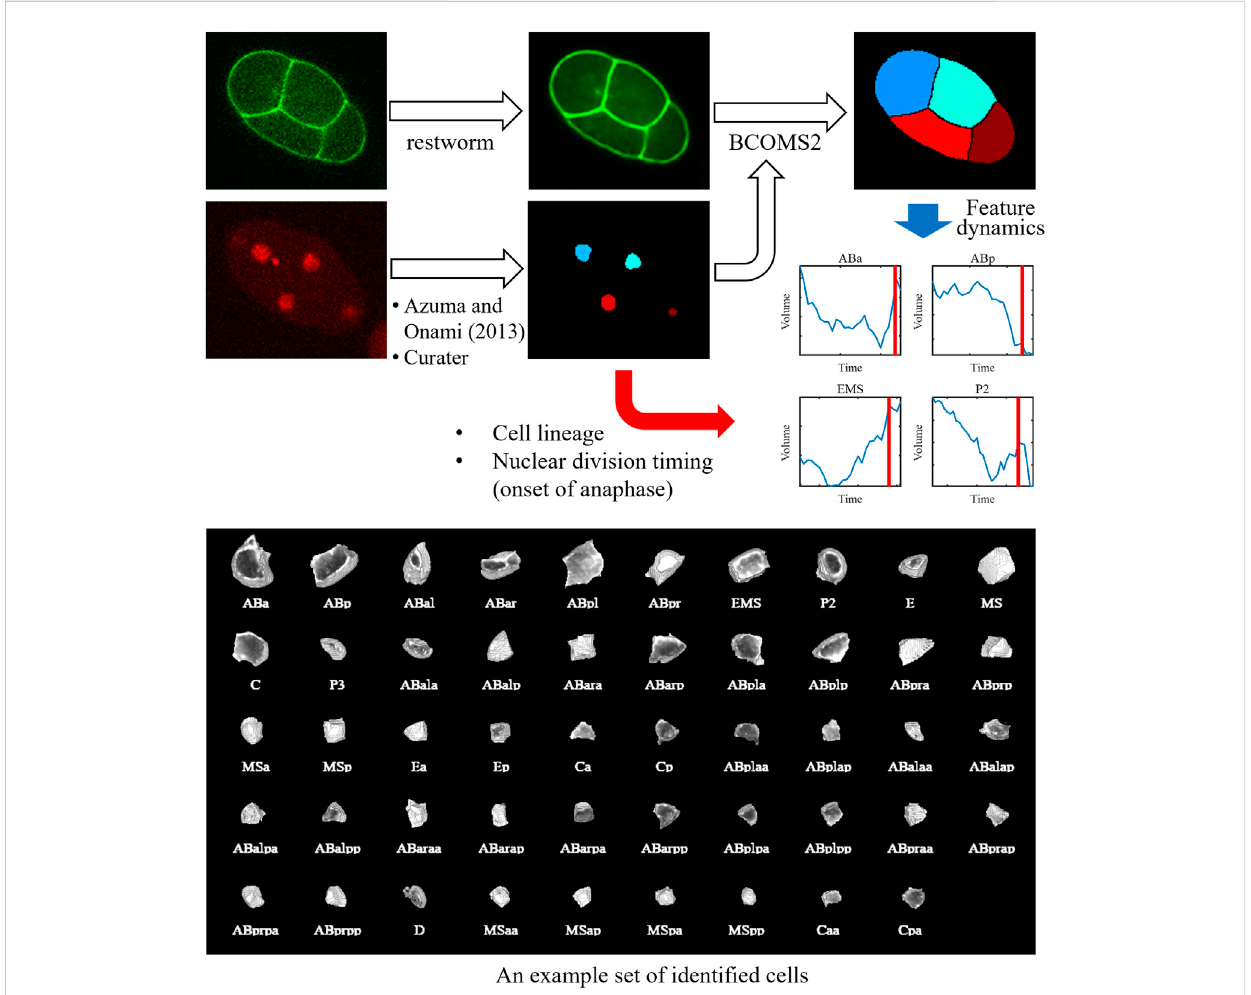
FIGURE 1 Schematic of the image processing pipeline and an exemplary segmentation result. The nucleus image is processed using a nucleus detection method developed previously. The result is manually curated using Curater, providing errorless nucleus detections. Each nucleus is also annotated using Curater. The membrane image is denoised using restworm. The restored membrane image and processed nucleus detection results are input to BCOMS2. BCOMS2 performs membrane segmentation and extracts morphological features, providing feature dynamics of the identi fi ed cells. The annotations for the nuclei are assigned for the cells, and the nuclear division timings are used to provide the timings of anaphase